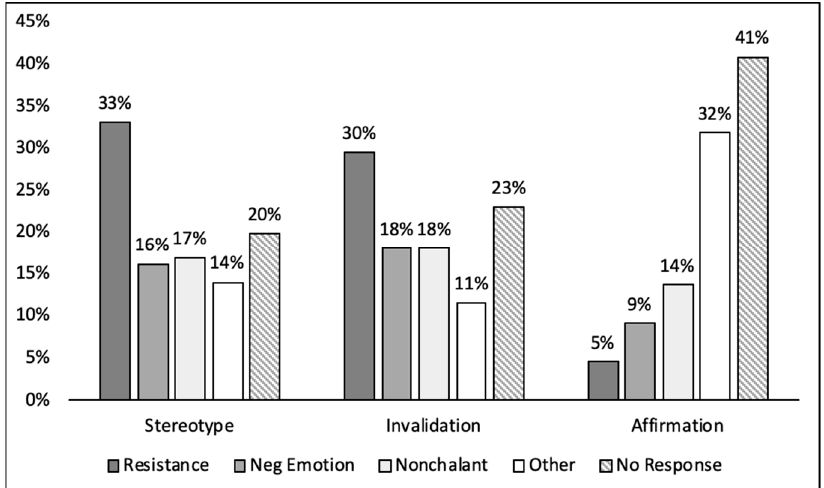
Figure 3. Distribution of Reaction codes within each Message Type.